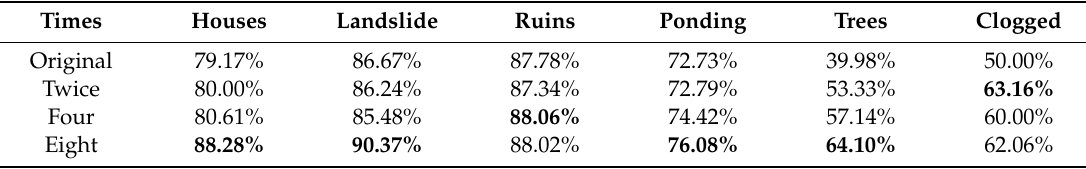
Table 7. F1 score results of the PEMSR method under various data volumes. The bold values are the best results for each scene.